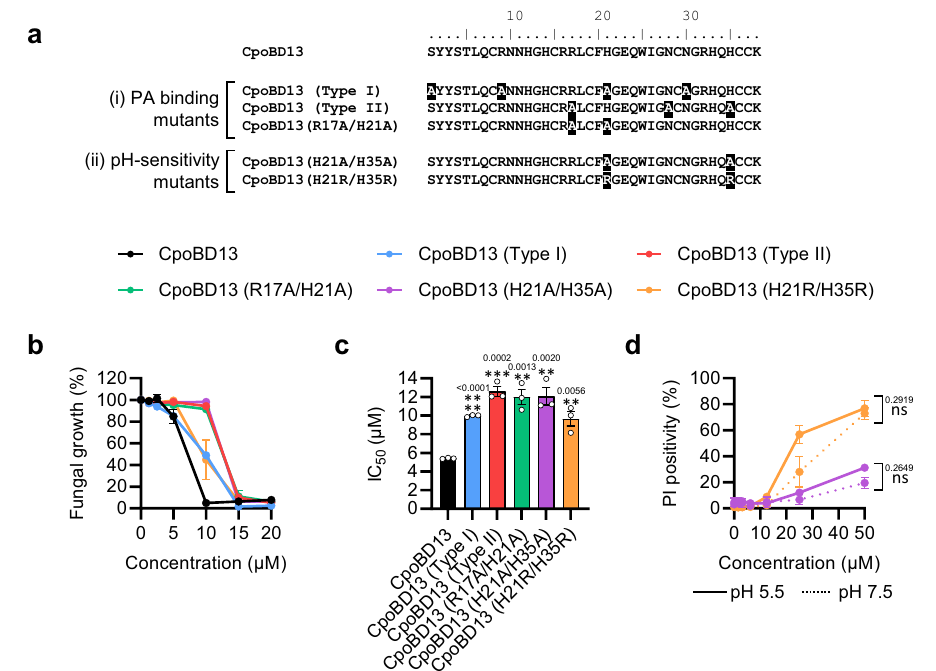
Fig.5|EffectsofcompoundmutationsinthePA-bindingsiteofCpoBD13onits antifungal activity. a Sequence alignment of CpoBD13 with the designed com- pound mutants. Residues that differ from wild type CpoBD13 are highlighted in black. b Fungal growth inhibition of C. albicans treated with a range of CpoBD13 and CpoBD13 compound mutant concentrations over 24h. Data represent mean±SEM, n =3. c Calculated IC 50 values of the fungal growth curves. Data represent mean±SEM, n =3. All statistical evaluations are comparisons to the